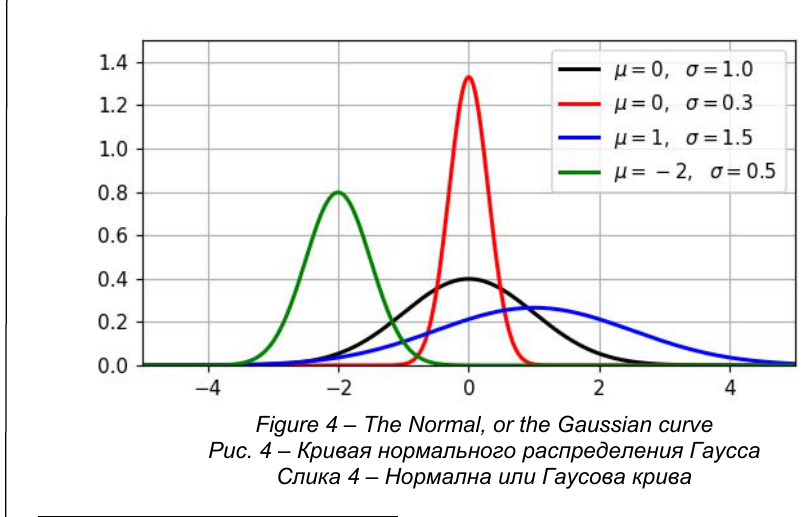
Figure 4 – The Normal, or the Gaussian curve Рис . 4 – Кривая нормального распределения Гаусса Слика 4 – Нормална или Гаусова